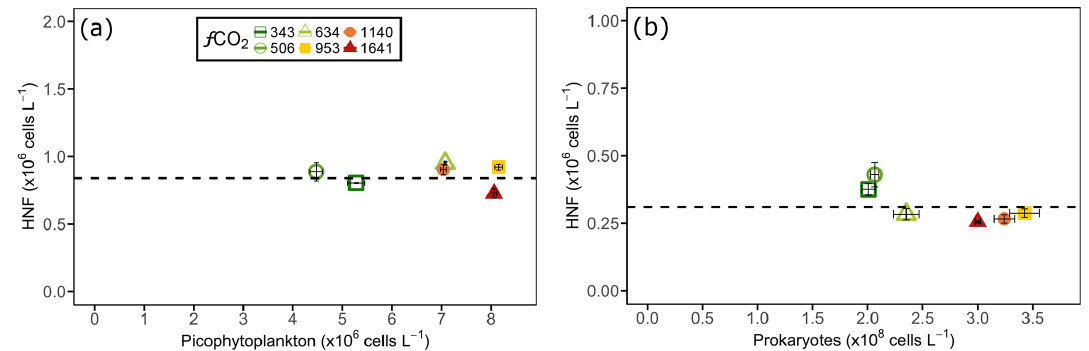
Figure 7. Heterotrophic nanoflagellate (HNF) abundance ( y axis) on the day before (a) picophytoplankton and (b) prokaryote abundance declined (shown on x axis) in each of the minicosm treatments. The error bars display standard error of pseudo-replicate samples of HNFs (vertical) as well as picophytoplankton and prokaryotes (horizontal). The dotted line indicates a threshold heterotrophic nanoflagellate abun- dance of (a) 0 . 87 ± 0 . 02 × 10 6 and (b) 0 . 32 ± 0 . 02 × 10 6 cellsL − 1